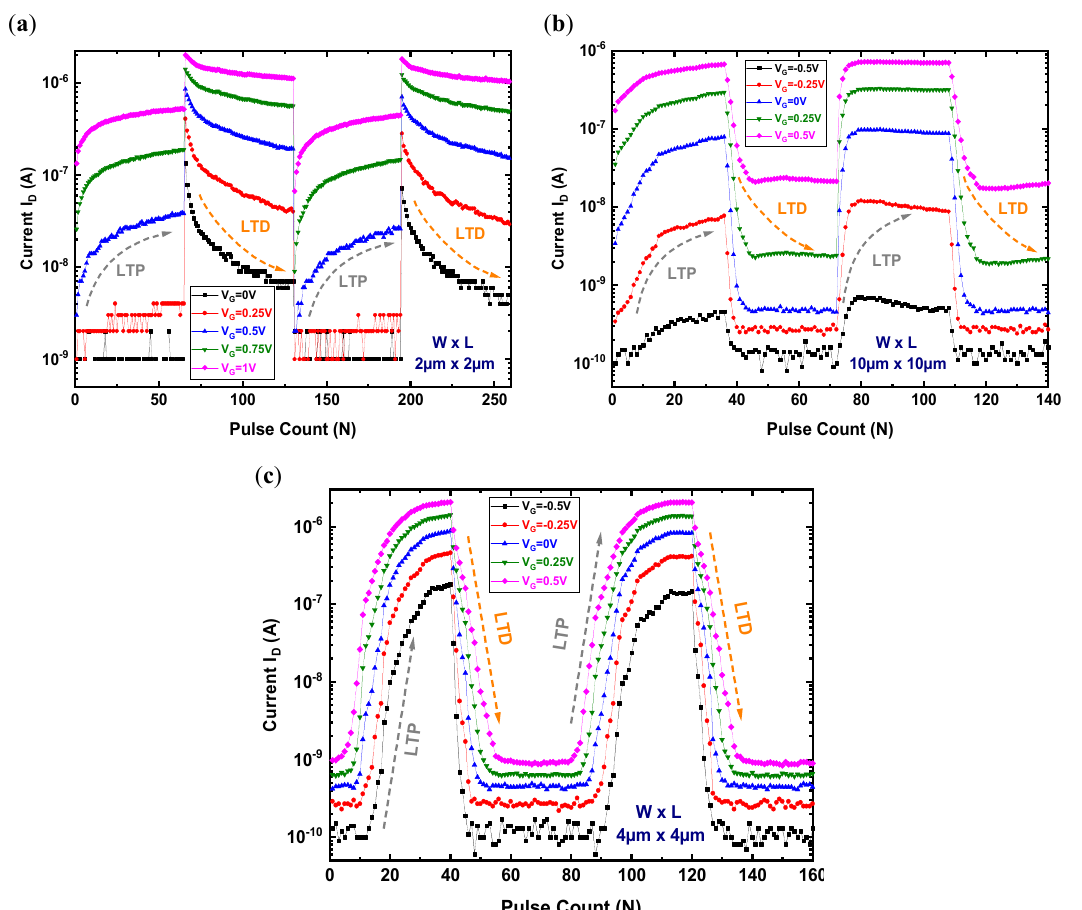
Figure 18. The laminate FeFET as a synaptic device shown by two cycles of the LTP/LTD operation using ( a ) PG/ER pulse train (sequence 1), ( b ) constant amplitude for the pulse width sweep (sequence 2), ( c ) constant pulse width for an amplitude sweep (sequence 3).